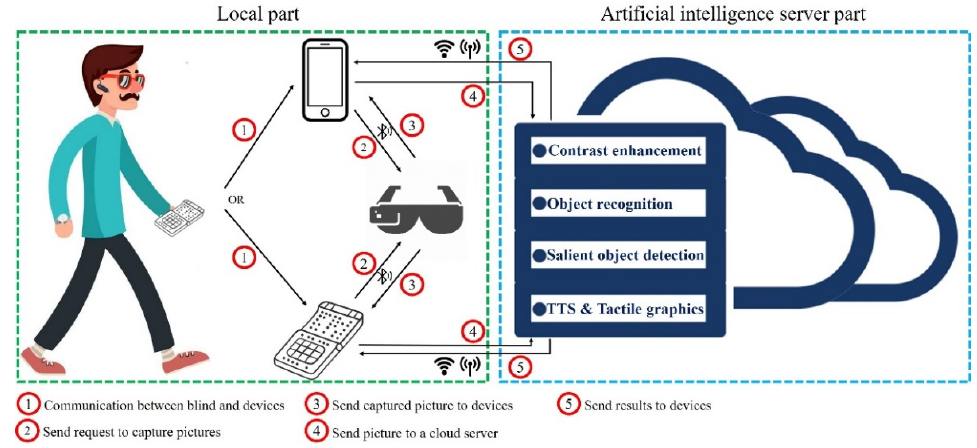
Figure 2. The overall design of the proposed system.